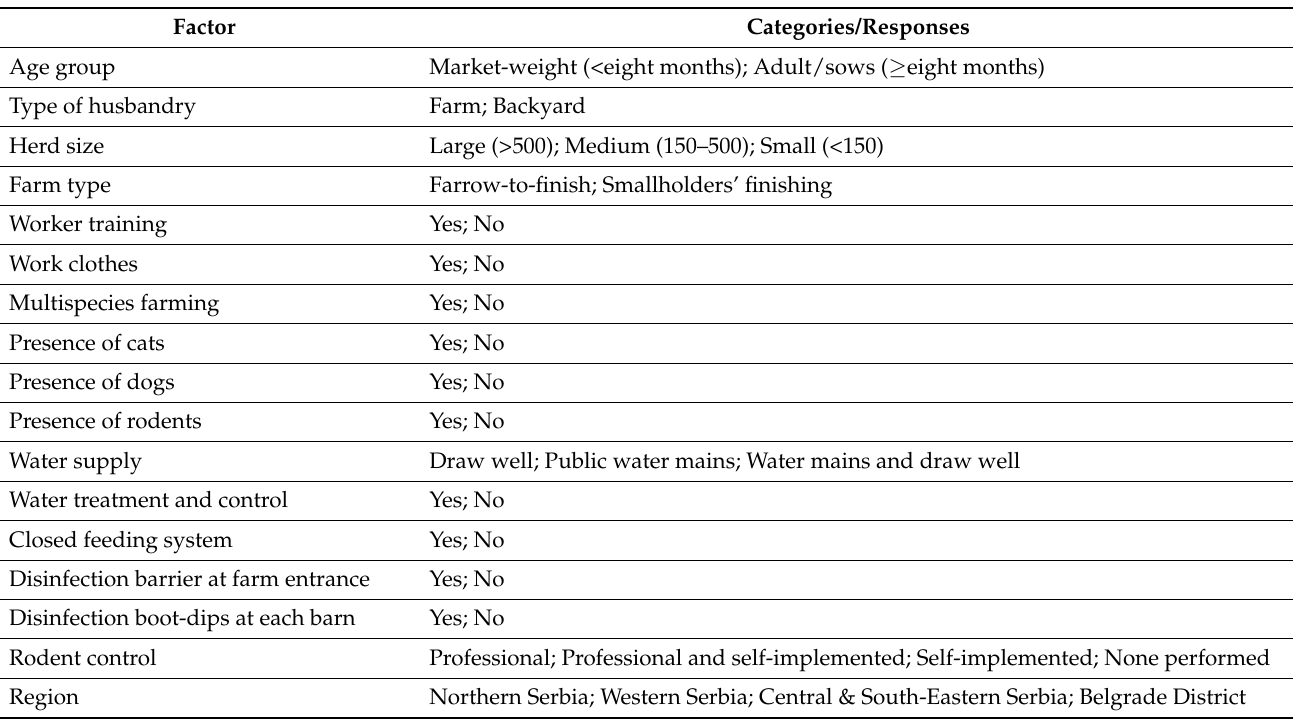
Table 1. Categories of data collected on plausible epizootiological risk factors for Toxoplasma gondii infection in pigs in